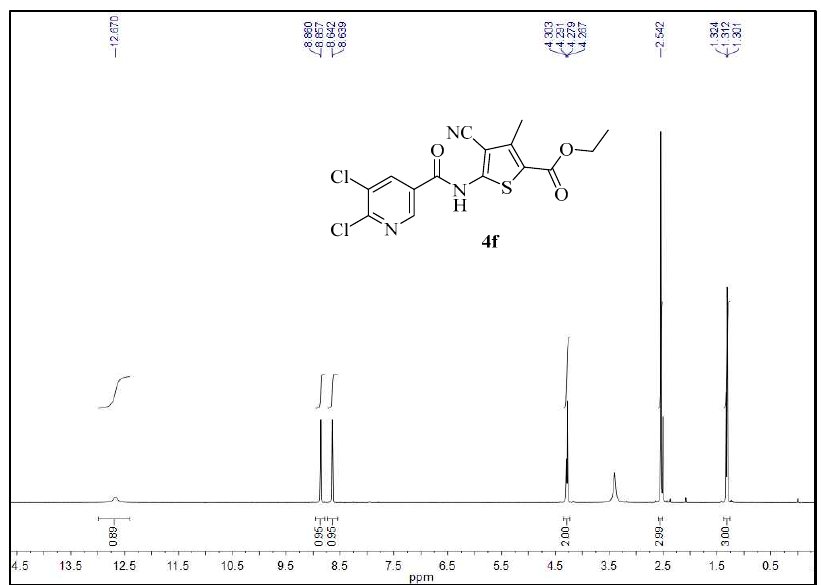
Figure 3. The 1 H NMR spectrum of compound 4f.